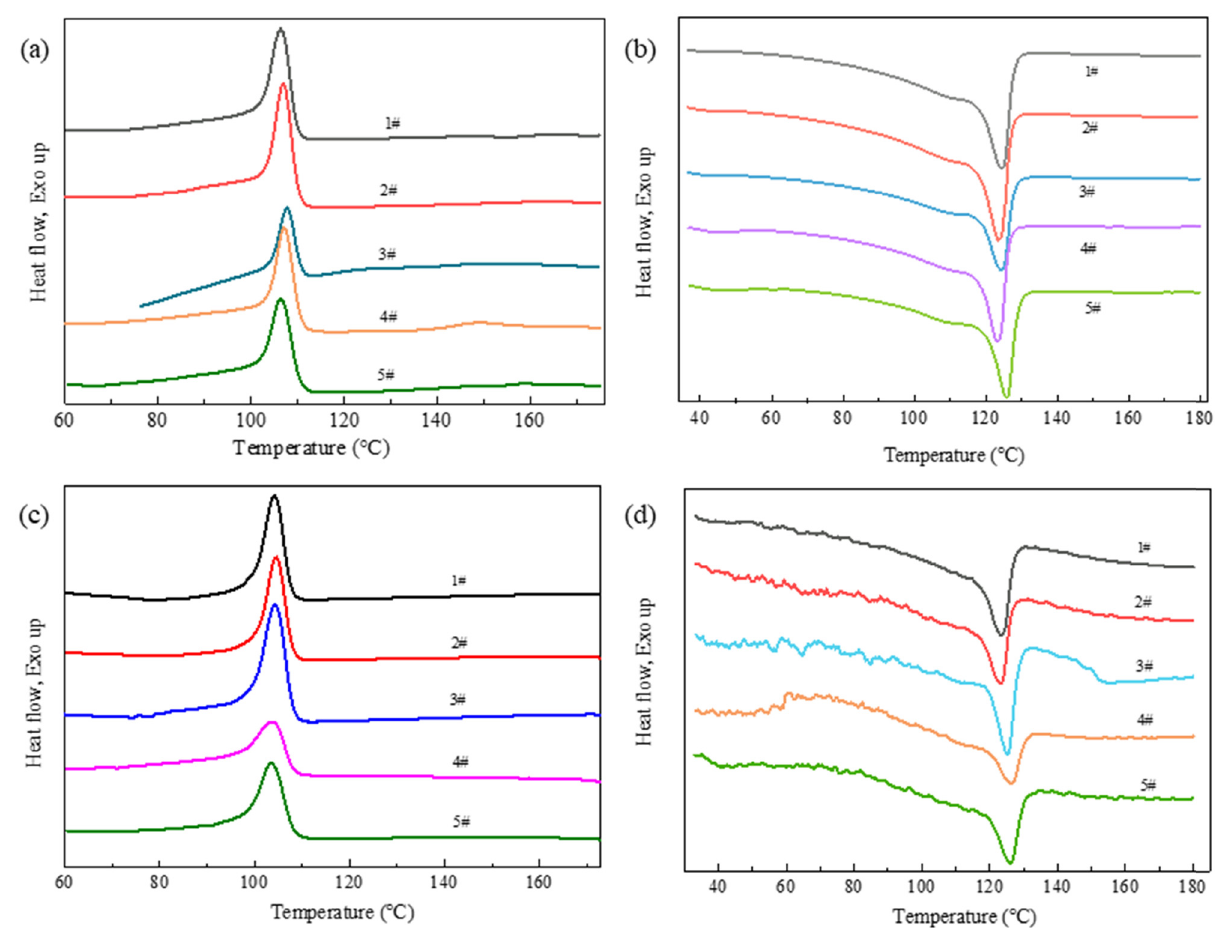
Figure 4: DSC curves of the HDPE composites with ( a ) cooling rate of 10°C · min − 1 under normal pressure, ( b ) heating rate of 10°C · min − 1 under normal pressure, ( c ) cooling rate of 10°C · min − 1 under high pressure, and ( d ) heating rate of 10°C · min − 1 under high